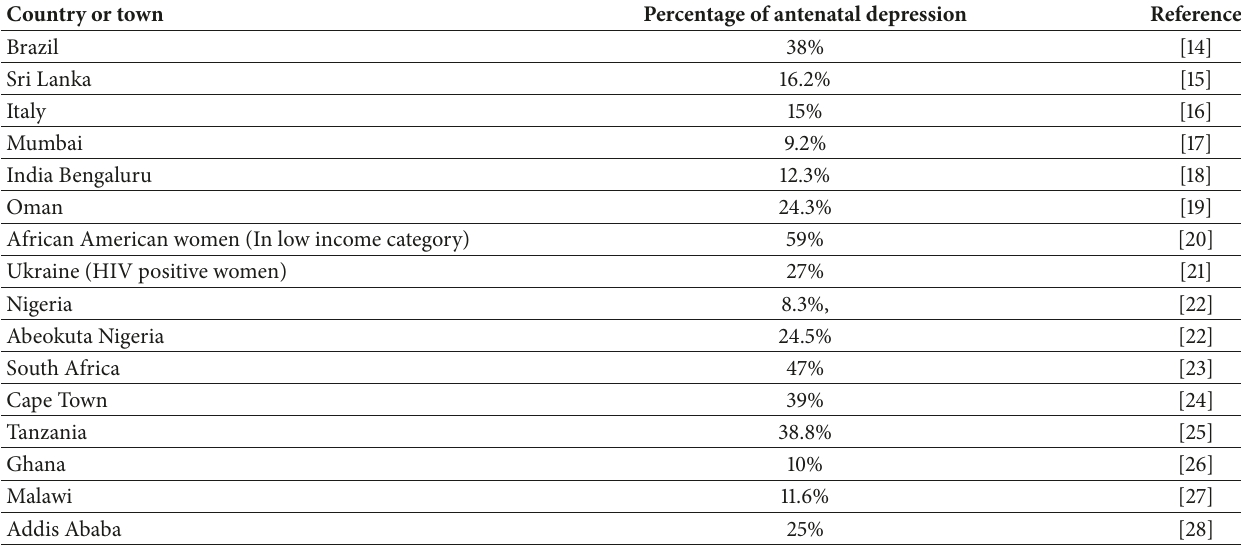
Table 1: Prevalence of antenatal depression in different parts of the